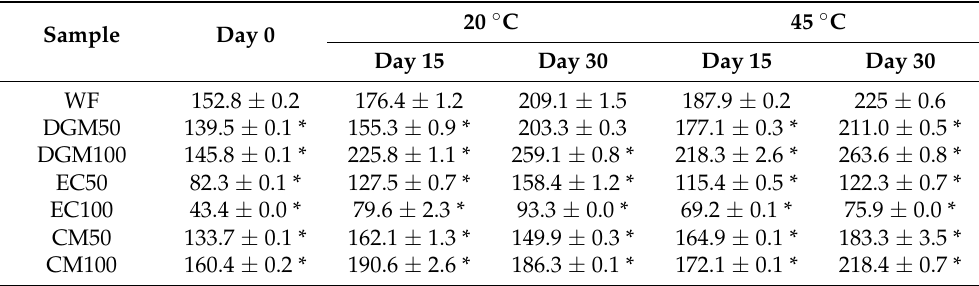
Table 5. Effect of addition of non-encapsulated (DGM), encapsulated (EC) and color-masked (CM) defatted Nannochloropsis oceanica to wheat flour (WF, control) on malondialdehyde levels ( µ mol MDA/g fat) 1